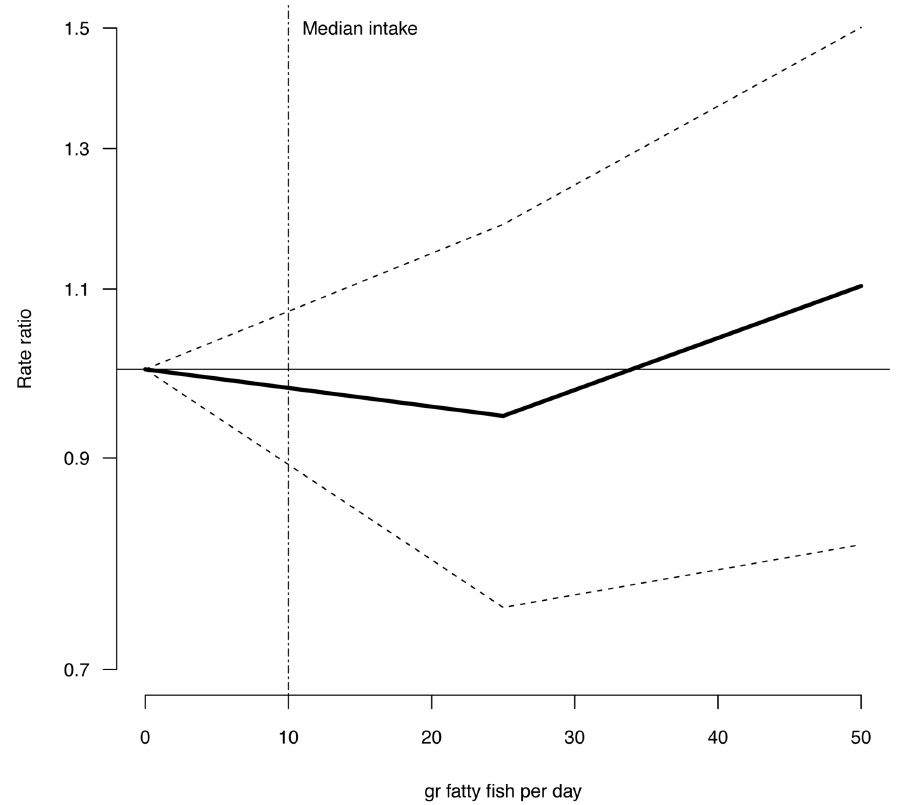
Figure 2. Risk ratios (RR) and 95% CI by fatty fish consumption. RRs are indicated by the solid line and the 95% CI by the dashed horizontal lines. Numbers are adjusted for BMI, hypertension, smoking status, age and physical activity. Median intake of fatty fish in the study group is indicated by the dashed vertical line.